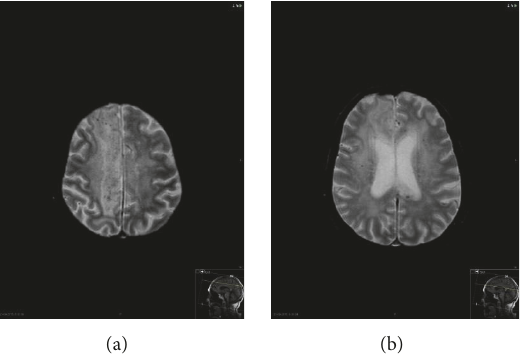
Figure 4: Axial T 2 ∗ . Punctate hypointensity foci of magnetic susceptibility diffusely in the central and subcortical cerebral white matter,withoutvasculardistribution,correspondingtohemosiderin